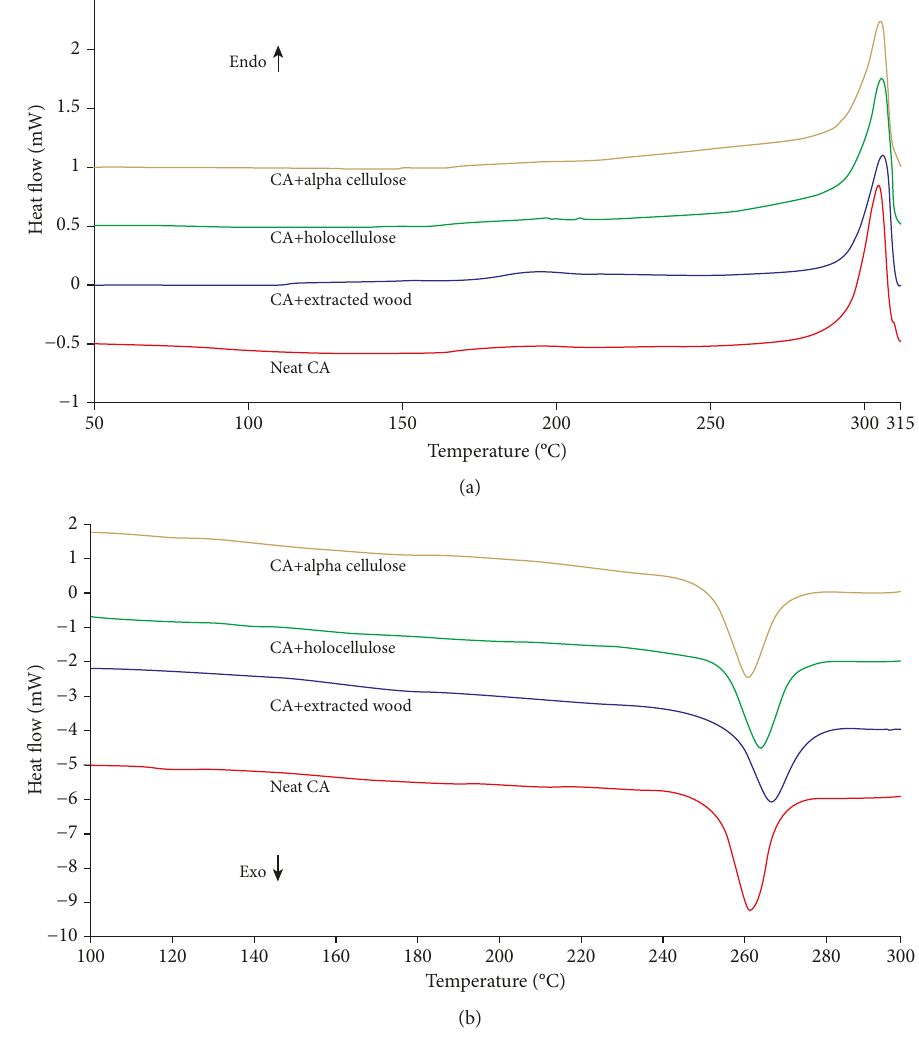
Figure 6: DSC curves of neat CA and biocomposites prepared from black alder: (a) heating endotherms; (b) cooling